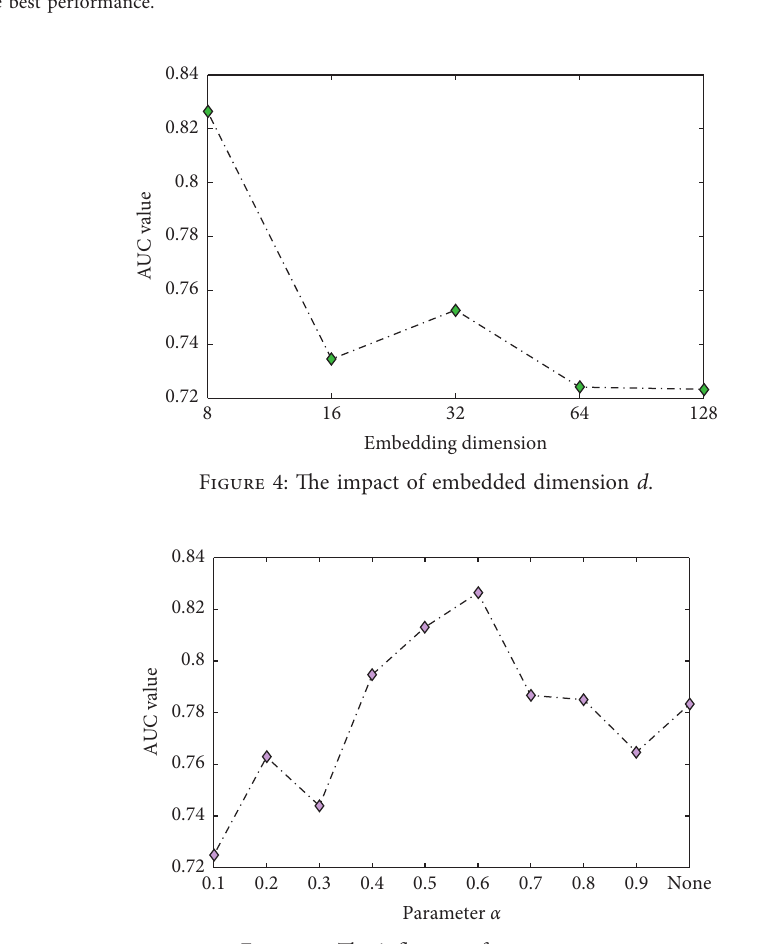
Figure 5: The influence of parameter α . Table 2: Top ten candidate circRNAs for